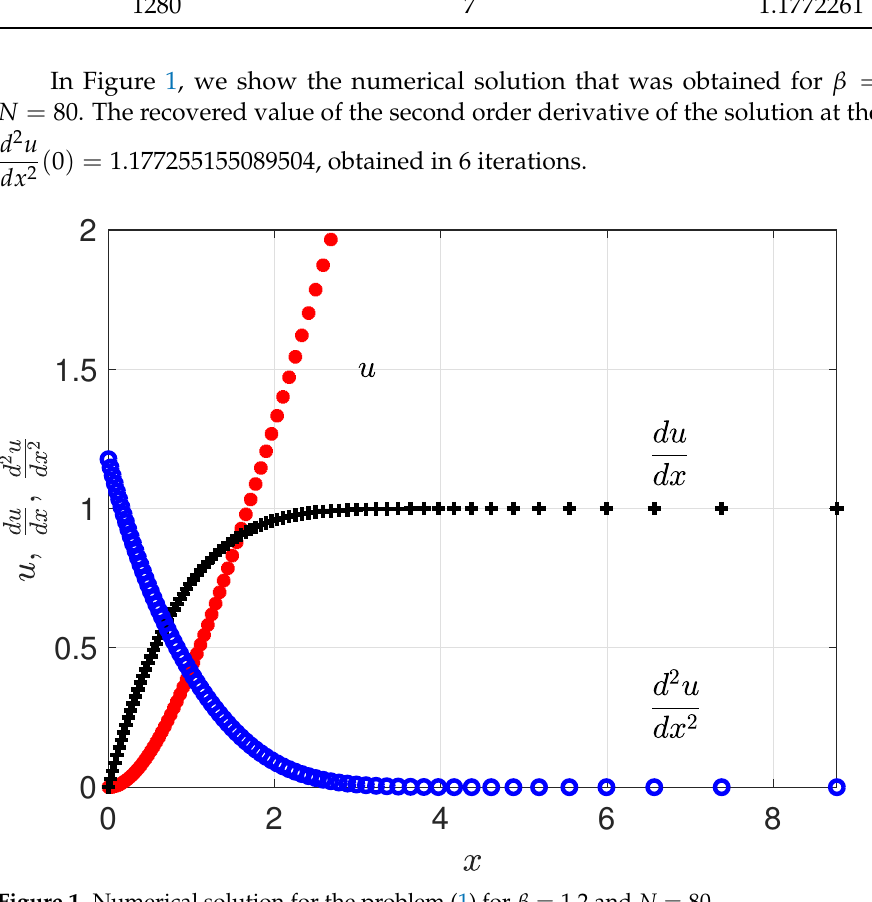
Figure 1. Numerical solution for the problem (1) for β = 1.2 and N =